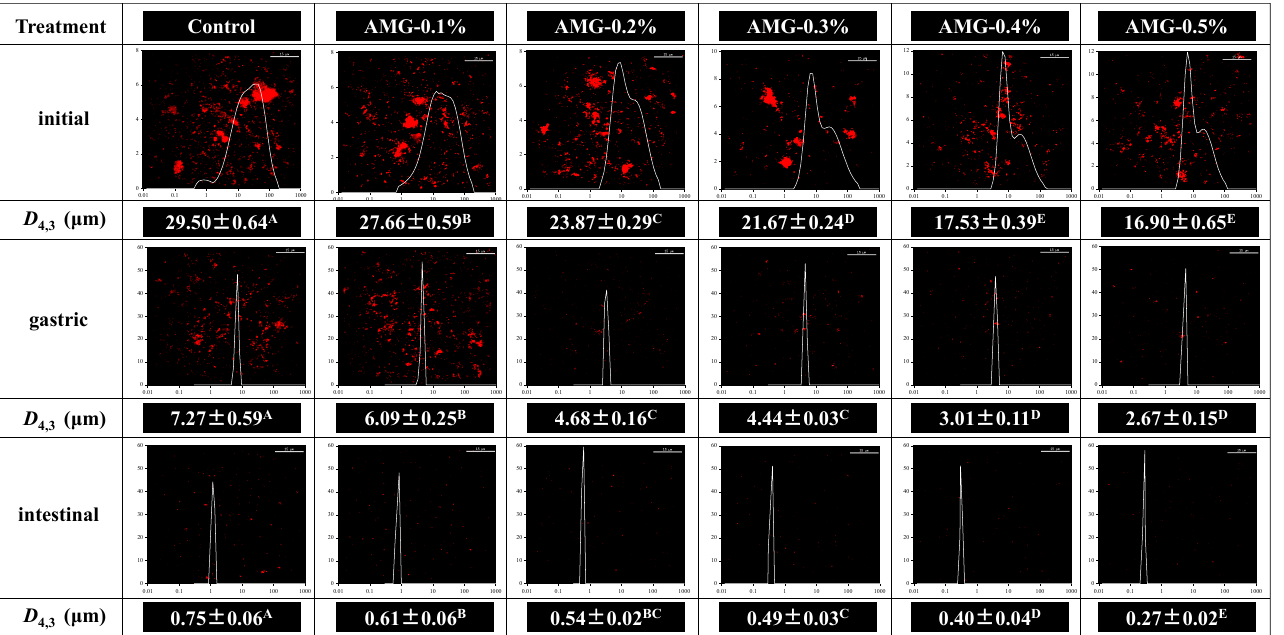
Figure 5. Microstructure and particle size distribution of the digestion samples of frankfurters with or without AMG at different concentrations. A–E in each column represent statistically significant differences ( p < 0.05). Control: no added AMG; AMG-0.1%: 0.1% added AMG; AMG-0.2%: 0.2% added AMG; AMG-0.3%: 0.3% added AMG; AMG-0.4%: 0.4% added AMG; and AMG-0.5%: 0.5% added AMG.